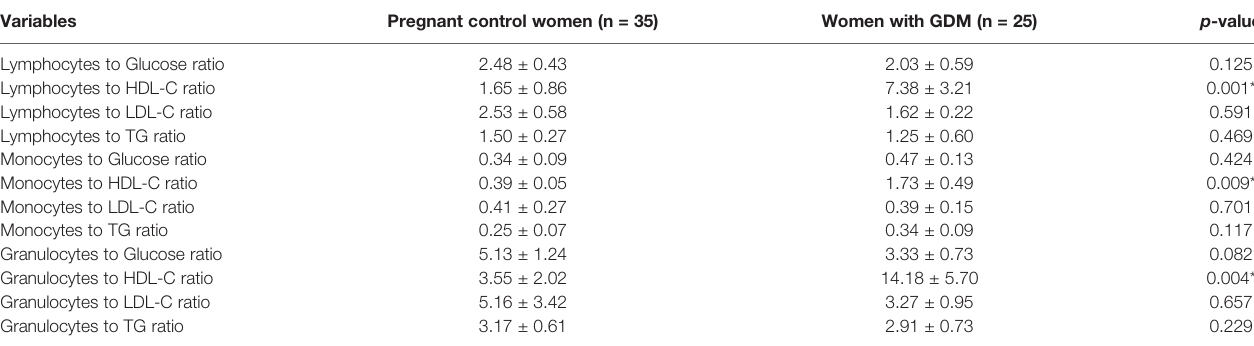
TABLE 5 | Ratios between immune cells to biochemical parameters in women with GDM (n = 25) and pregnant control women (n = 35).